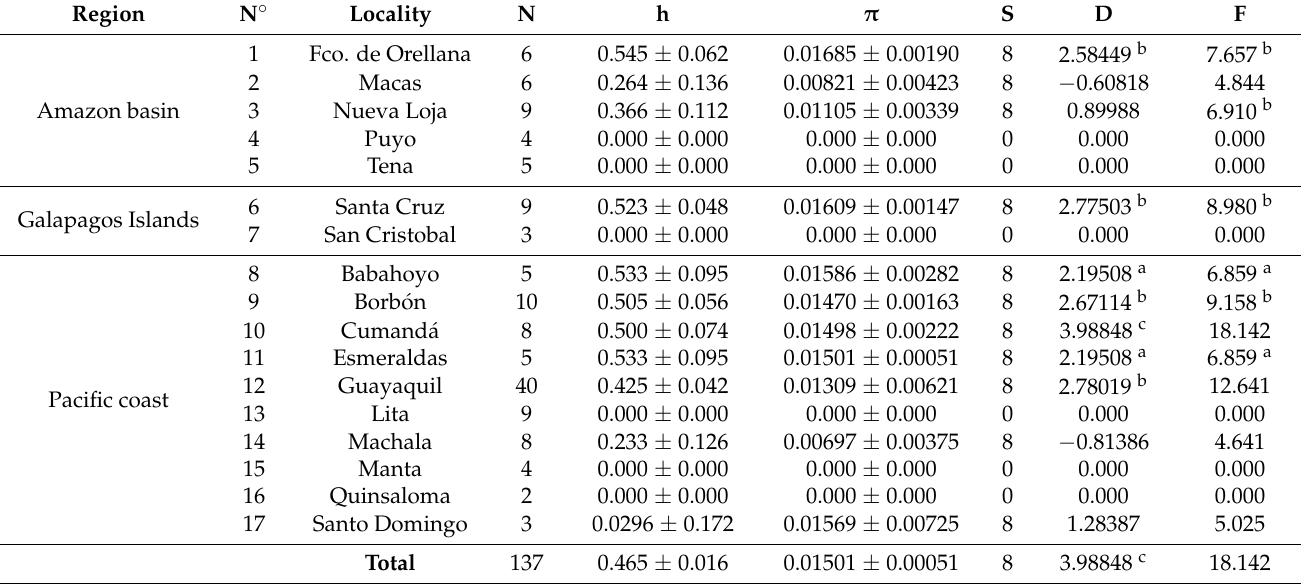
Table 3. Genetic diversity of the 17 Aedes aegypti populations from Ecuador. N refers to the number of individuals.